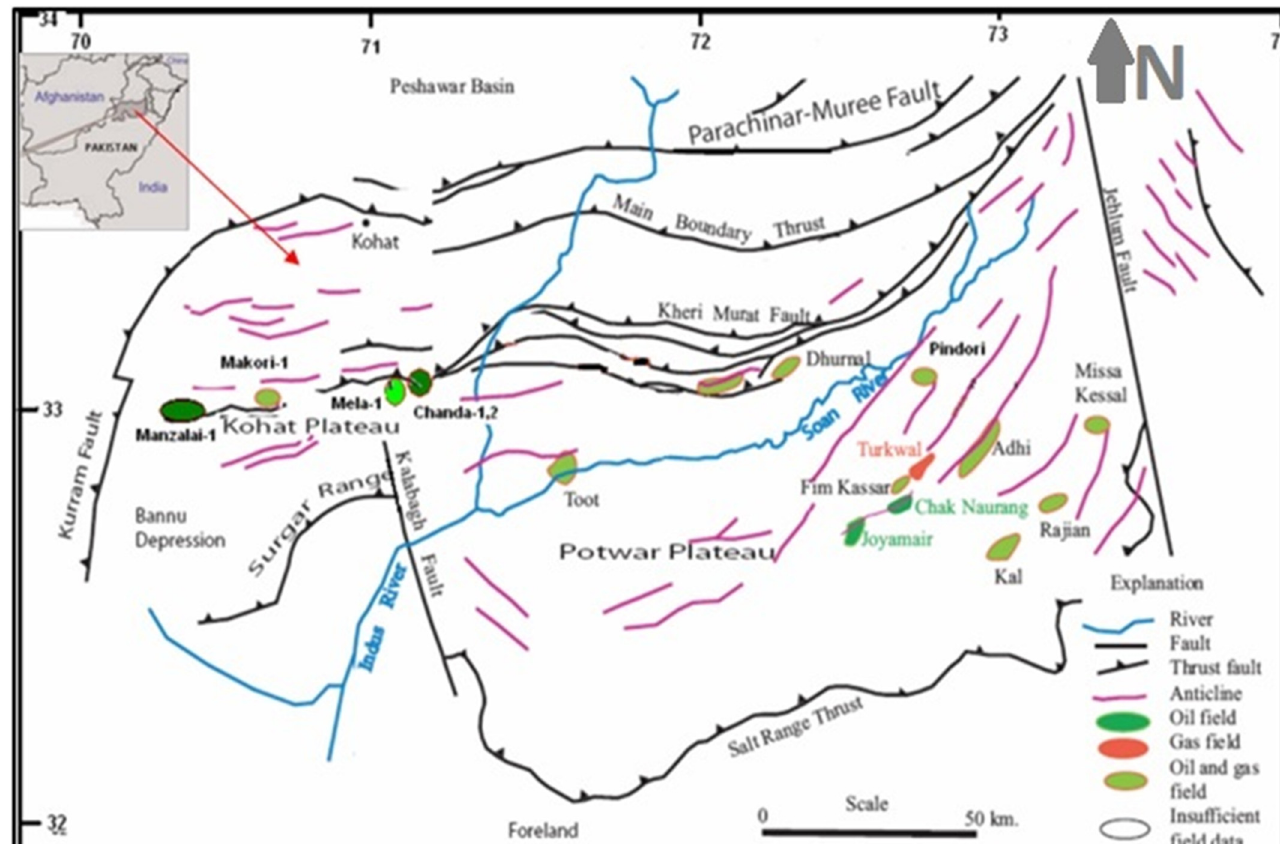
Figure 1. Location and geographical map of the Kohat Basin indicating different features, such as a river, faults, oil and gas fields, etc. (modified from [20]).